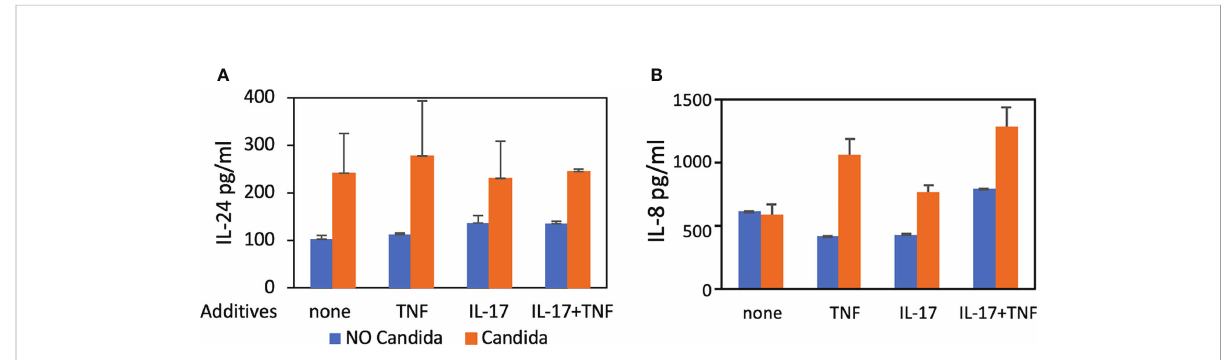
FIGURE 1 ELISA. Detection of IL-24 and IL-8 protein levels following co-culture of UV-treated C. albicans SC5314 germ tubes and primary human oral keratinocytes (MOI 10:1) for 48 hours in the presence of TNF (10 ng/mL) and/or IL-17 (100 ng/mL). (A) The amount of IL-24 secreted in the presence of germ tubes (M = 248.5 pg/mL) was signi fi cantly greater than controls (M = 121.9 pg/mL) P < 0.05. (B) The amount of IL-8 was increased in the presence of germ tubes and TNF (M=1062.6 vs. 423.9 pg/mL) or IL-17 (M=772.7 vs. 435.53 pg/mL) or both TNF and IL-17 (M=1289 vs. 796.5 pg/mL) P < 0.05 but not in the presence of germ tubes alone (M=596.2 vs. 622.4 pg/mL) P =